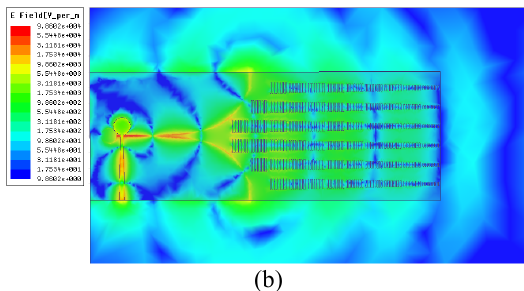
Figure 7: Electric field distributions at 9 GHz, (a) Reference TSA and (b) GRIN TSA.